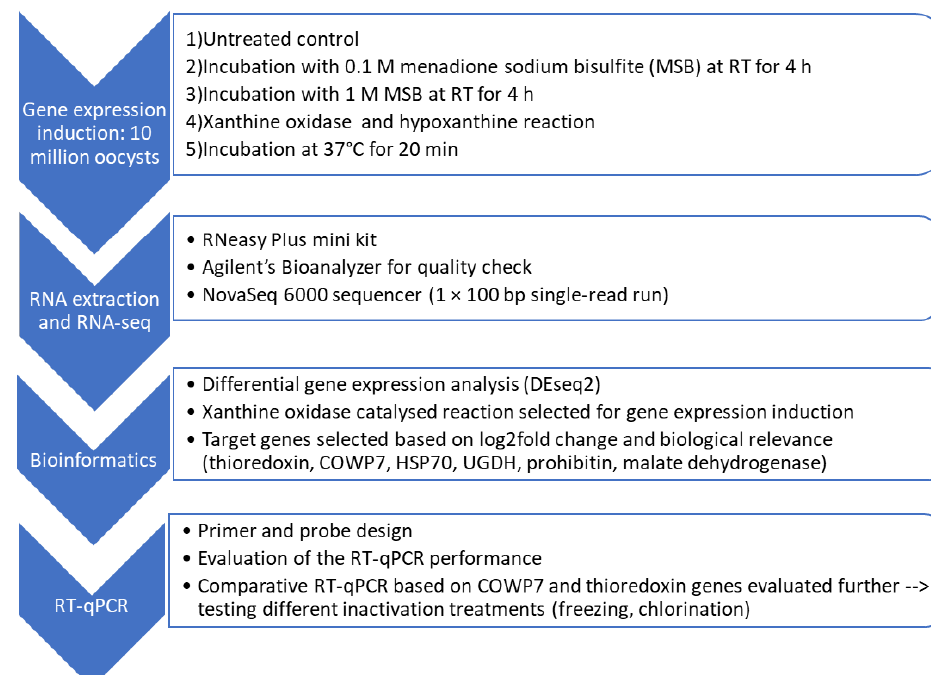
Figure 1. Flow chart indicating the 4 stages of the RT-qPCR method development.